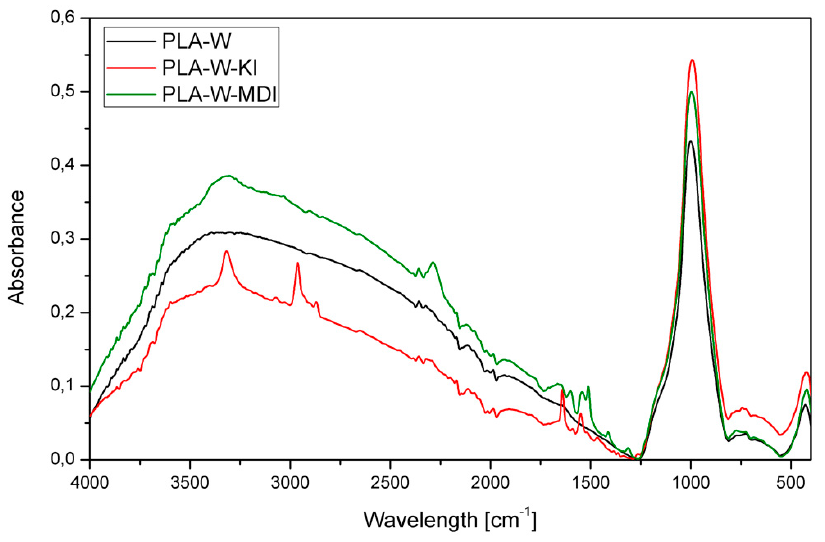
Figure 6. FTIR spectra of unmodified vermiculite and series subjected to mechanochemical modifi-